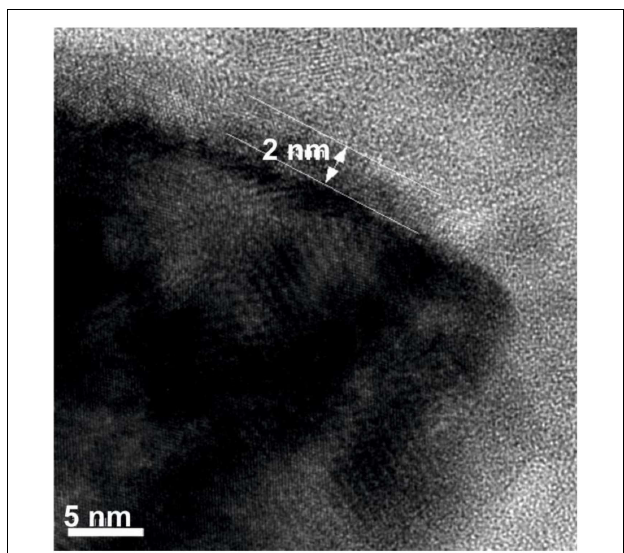
with a high and a low filling factor, respectively, within porous silicon.